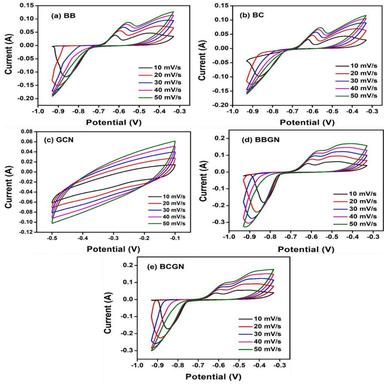
CV curves at different scan rates for (a) BB, (b) BC, (c) GCN, (d) BBGN and (e) BCGN electrodes.